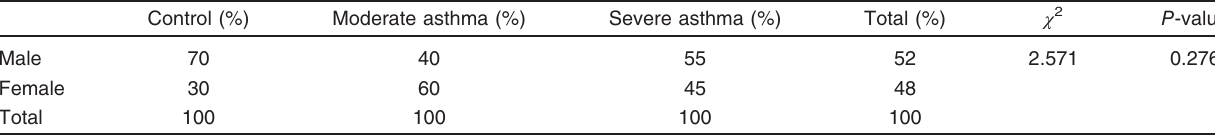
Table 2 Statistical comparison of the percentage of sex in the studied groups Control (%)